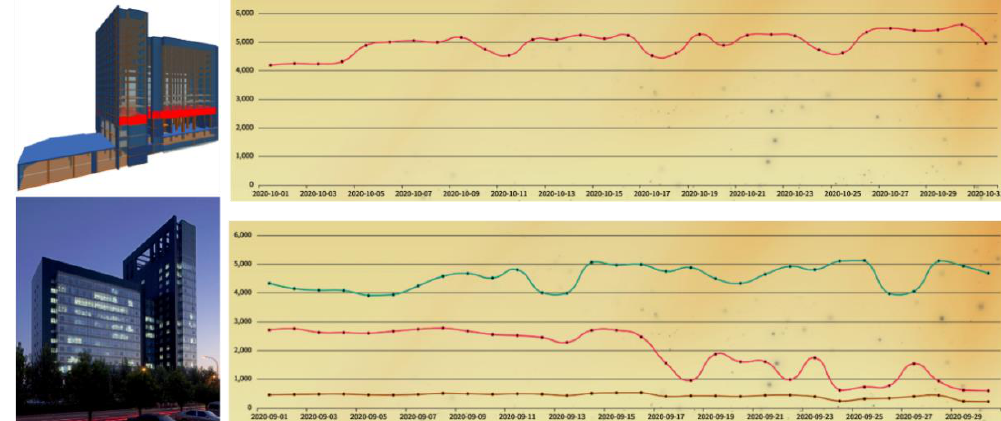
Figure 9. BIM model, photo, and monitoring data of Dalian University of Technology Innovation Park Building.